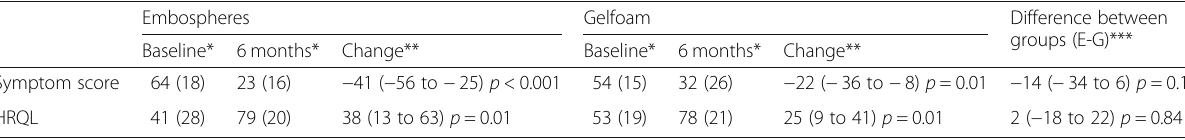
Table 5 Effect of embolic agent on UFS-QoL symptom score and HRQL